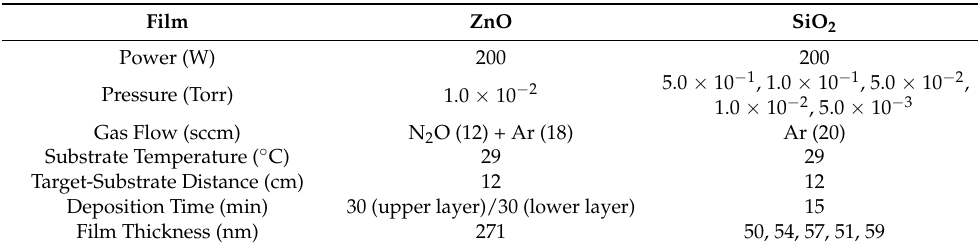
Figure 9 . SEM images obtained at 200 k times magnification showing the surface morphologies of the SiO 2 thin films deposited under three different working pressures: ( a ) 5.0 × 10 − 1 , ( b ) 5.0 × 10 − 2 , and ( c ) 5.0 × 10 − 3 Torr. Deposition power was fixed at 200 W. Table 3. Deposition conditions of both ZnO and SiO 2 thin films used to fabricate the ZSZ ‐ MGs in Figure 8.